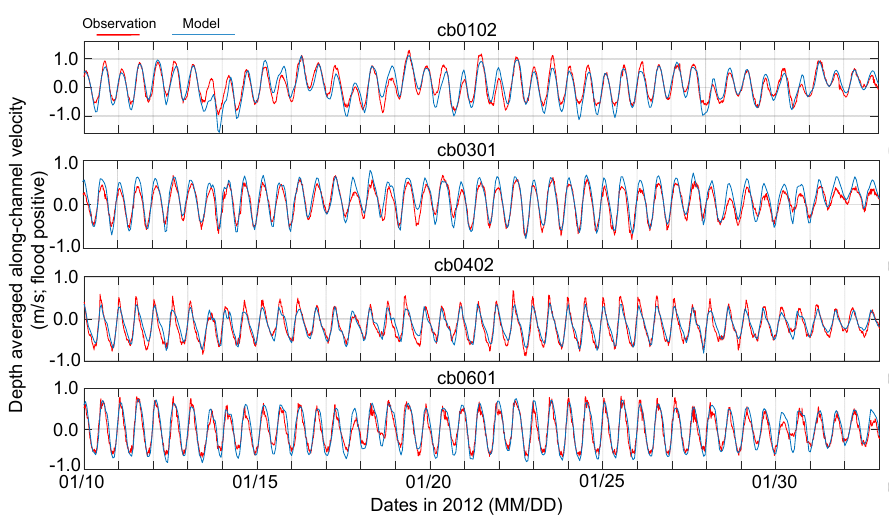
Figure 8. Sample model-data comparison on the depth-averaged along-channel velocity at National Oceanic and Atmospheric Administration (NOAA) current stations (see locations in Figure 1).